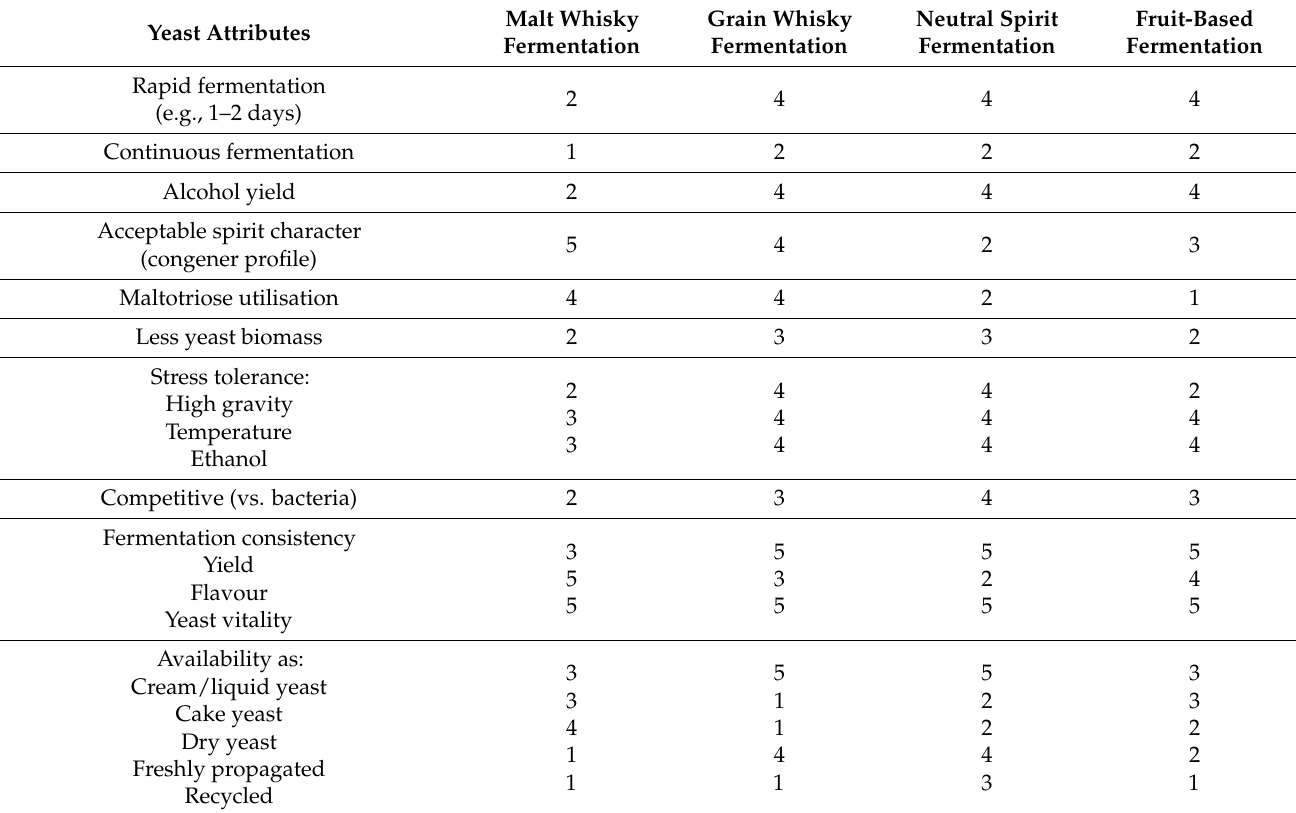
Table 5. Distilling yeast desired attributes: qualitative criteria (adapted from